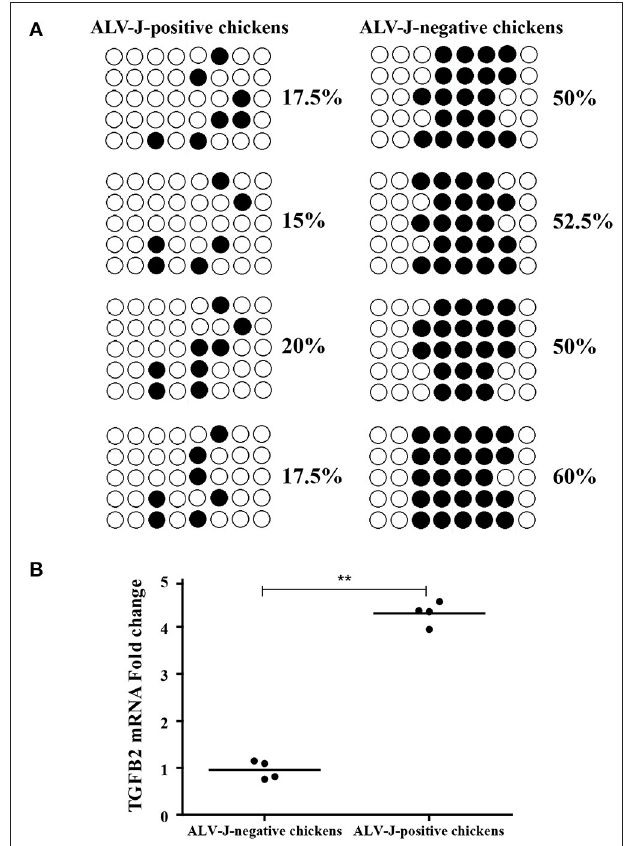
FIGURE 9 | Identification of TGFB2 methylation level and expression in randomly selected chickens by bisulfite sequencing PCR (BSP) and qRT-PCR. (A) The methylation status of TGFB2 in promoter region was investigated among randomly selected chickens by BSP; (B) relative expression of TGFB2 in randomly selected chickens. Data represent means ± SE. ** p <